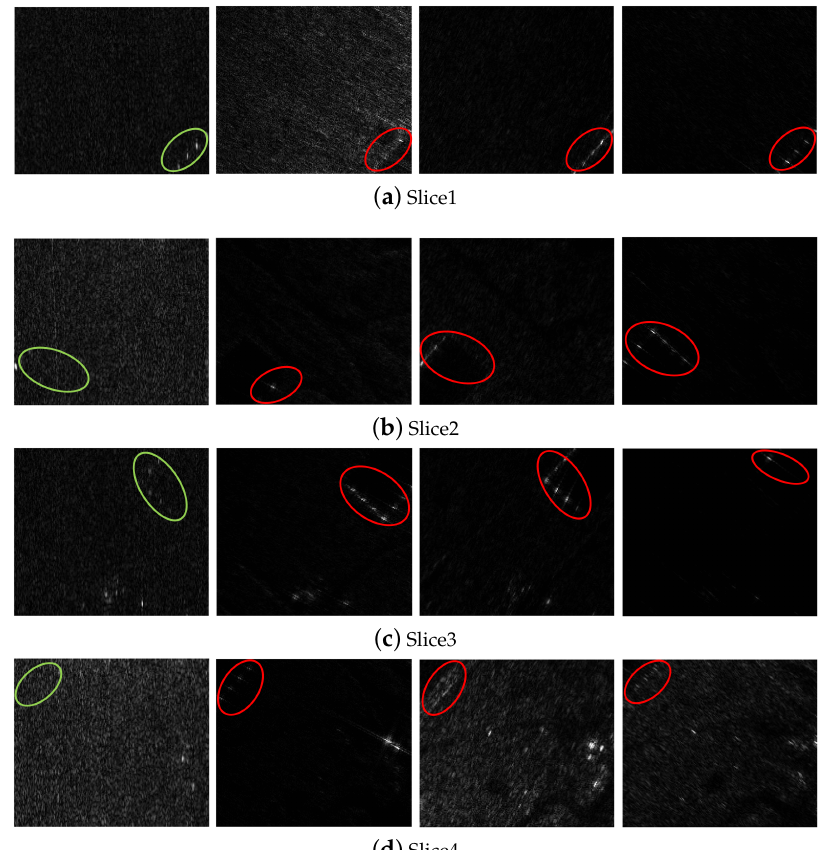
Figure 13. Backscattering comparison of multi-aspect slices containing different warehouse parts: ( a ) Slice1: Multi-aspect slice containing the upper left part of the warehouse (167th, 100th, 200th, 300th angle slices from left to right); ( b ) Slice2: Multi-aspect slice containing the upper right part of the warehouse (167th, 100th, 200th, 300th angle slices from left to right); ( c ) Slice3: Multi-aspect slice containing the lower left part of the warehouse (170th, 100th, 200th, 300th angle slices from left to right); ( d ) Slice4: Multi-aspect slice containing the lower right part of the warehouse (169th, 100th, 200th, 300th angle slices from left to